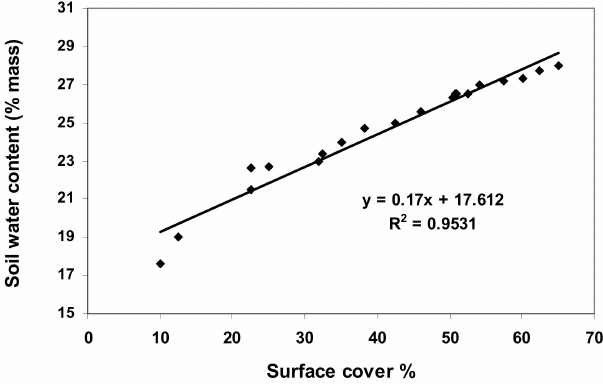
Figure 3. Soil water content ( w / w − 1 ) at di ff erent soil surface cover of the cereal and wide row crop stubbles.